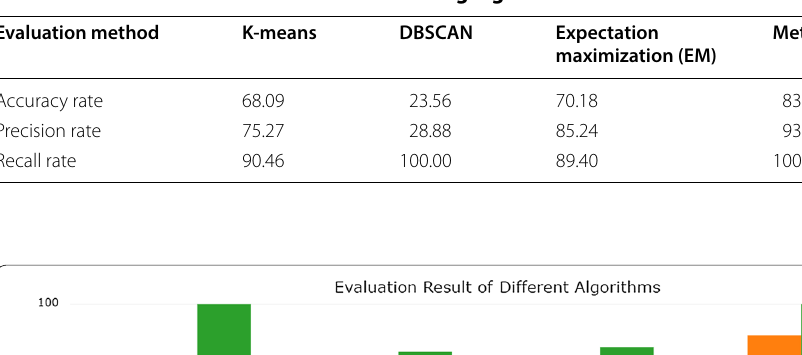
Table 4 Evaluation result of different clustering algorithms